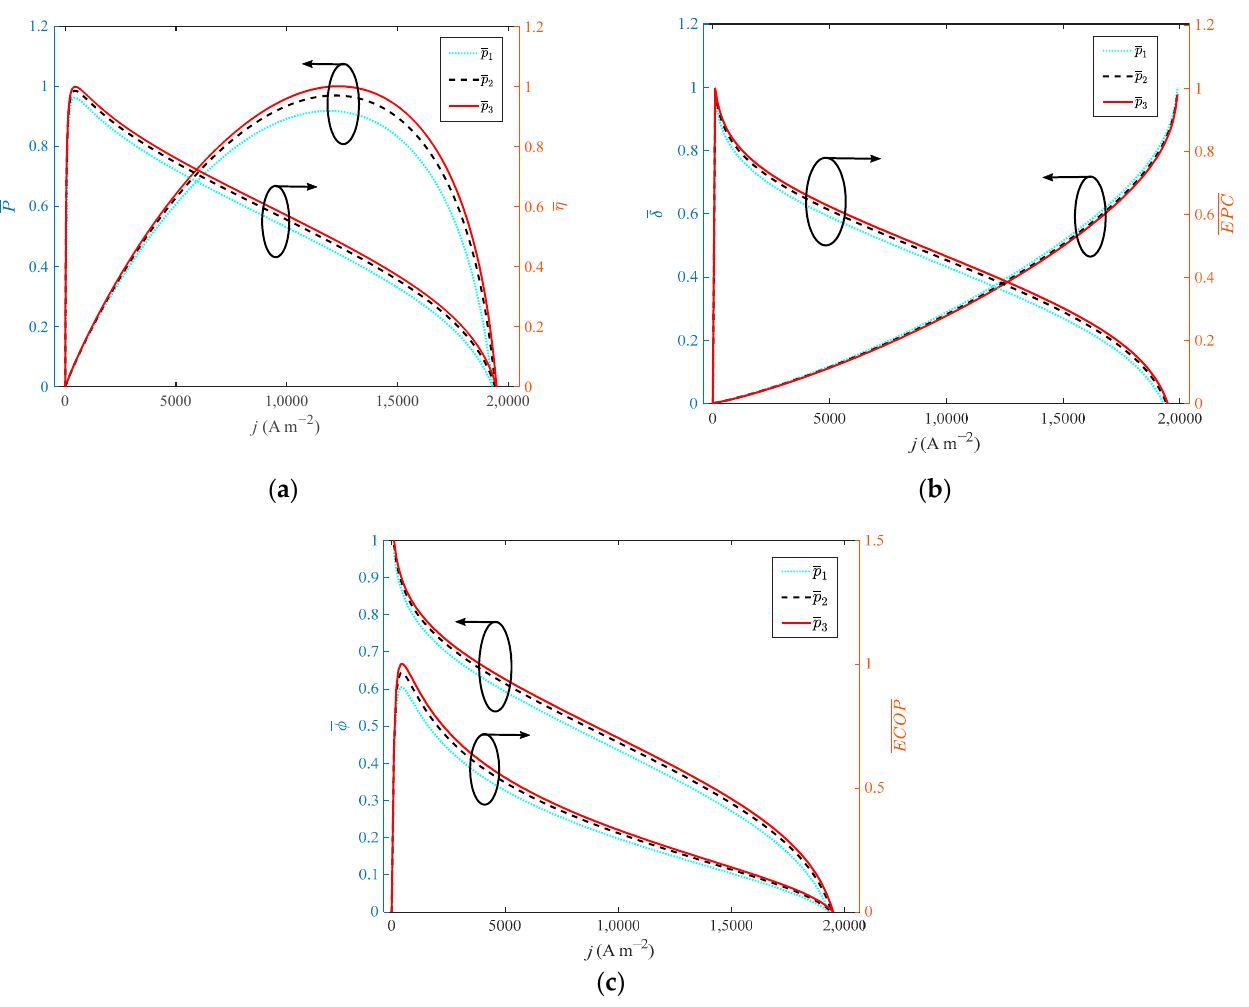
Figure 4. Different indexes vary with current density at different operating pressures: ( a ) P and η ; ( b ) δ and EPC ; ( c ) φ and ECOP .